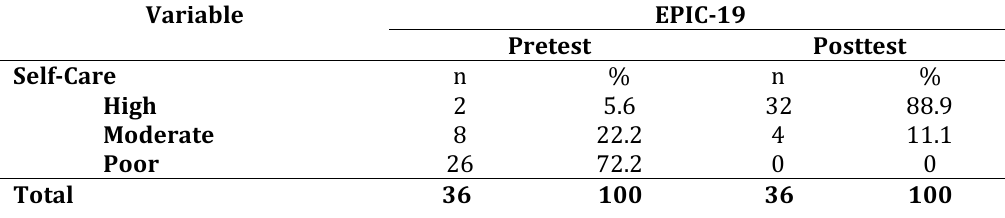
Distribution of the Level of Self-Care Practice Variable